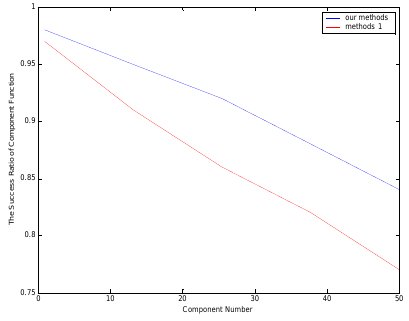
Fig.3. the relationship between the component numbers with the success ratio of component function.